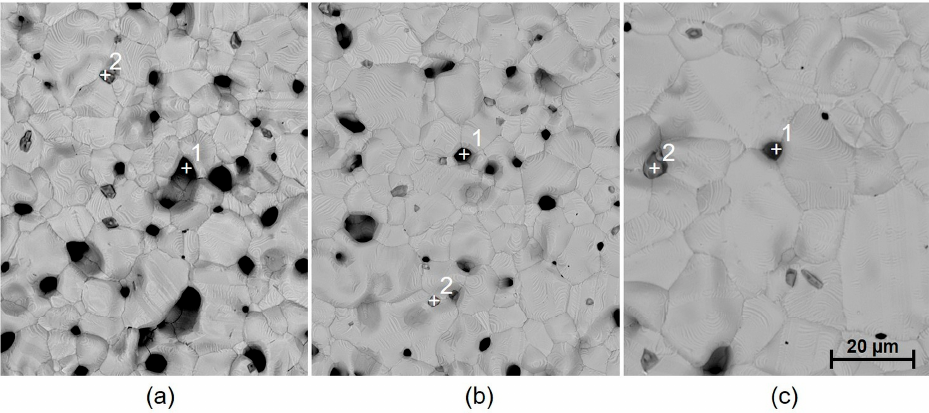
Figure 8. SEM image of the surface of fired paste C1076SD: ( a ) 1 layer and 1 firing (specimen group 2), ( b ) 2 layers and 2 firings (specimen group 6), and ( c ) 2 layers and 2 firings, followed by a two-hour annealing (850 ◦ C). Spot 1, pores; spot 2, Cu 2 O.